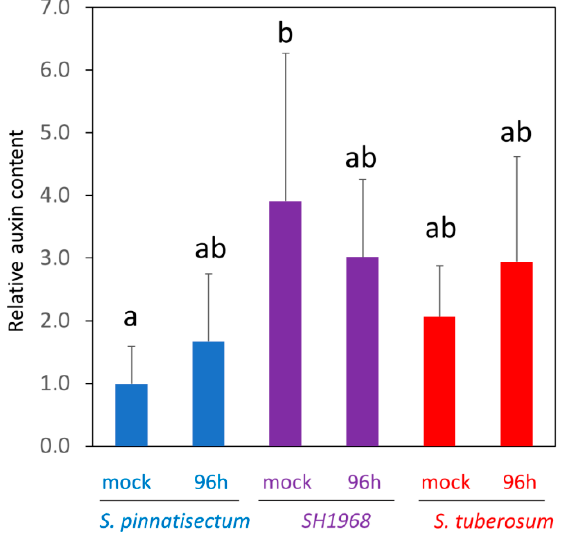
Figure 8. Relative auxin content in the inoculated and mock ‐ treated leaves. The results represent the means and standard deviations ( n = 5), and the different letters indicate significant differences (Kruskal–Wallis, p < 0.05). K, S. tuberosum cv. Kerkovsky rohlicek; P, S. pinnatisectum ; S, hybrid SH1968.